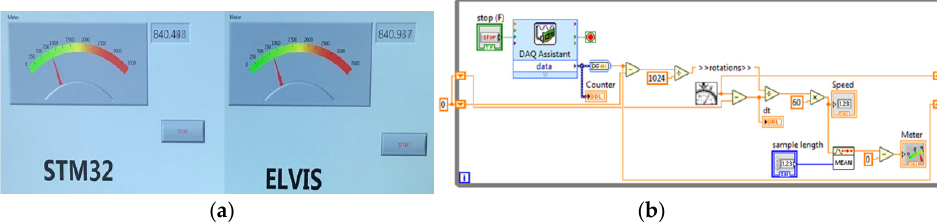
Figure 13. ( a ) The human–machine interface build in LabVIEW; ( b ) signal acquisition in NI-DAQmx.